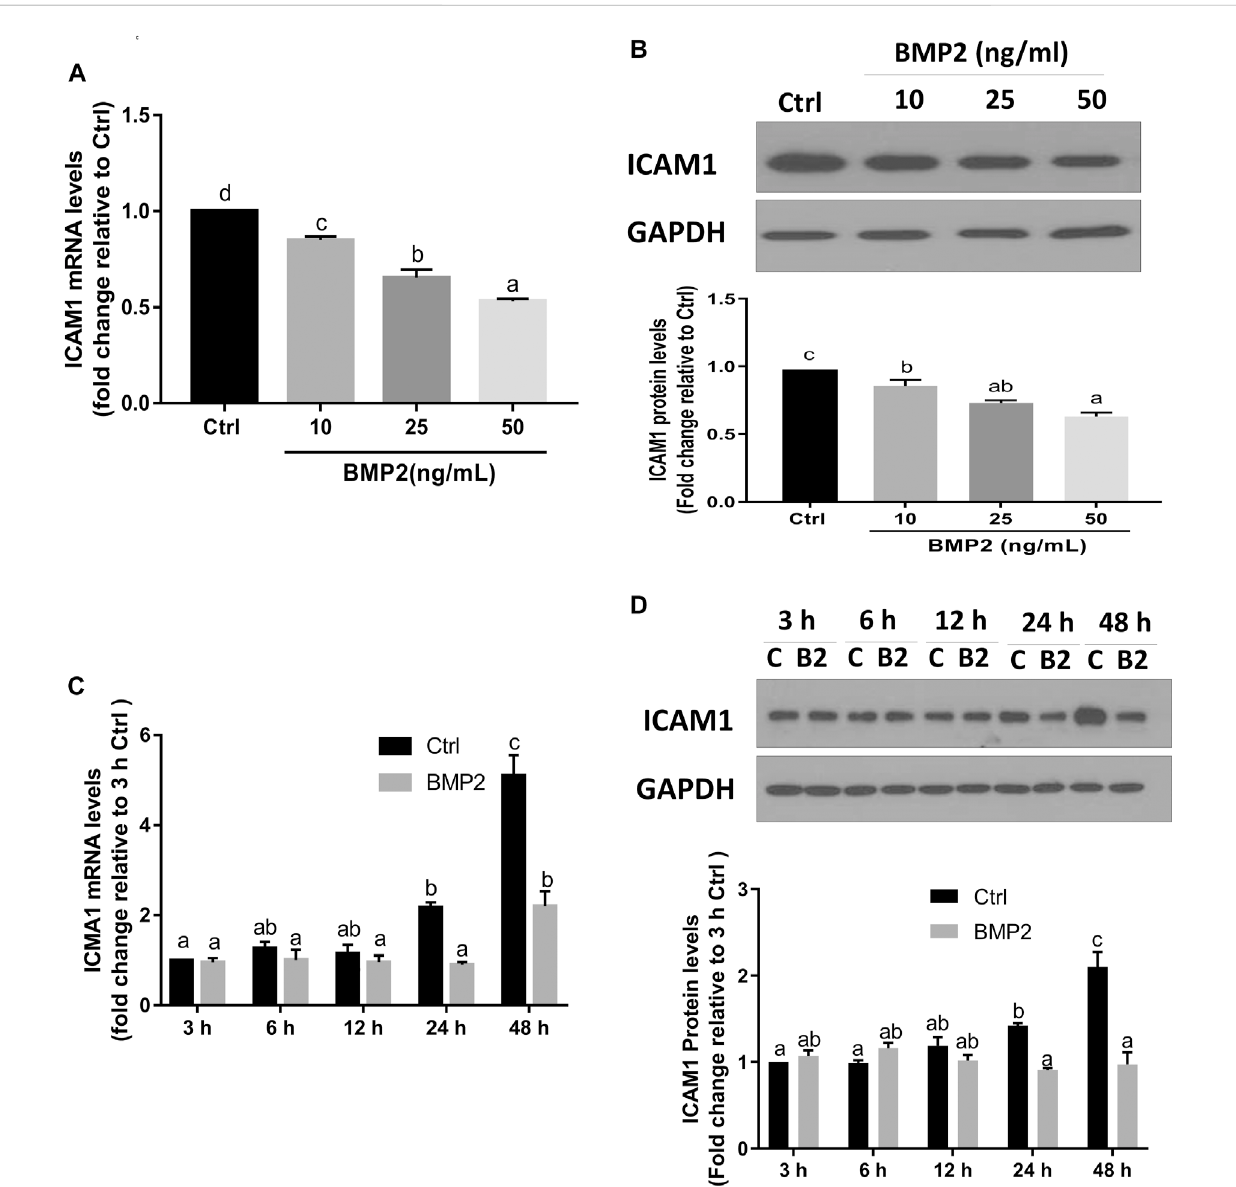
FIGURE 2 BMP2downregulatestheexpressionofICAM1innon-decidualizedHESCs. (A,B) HESCsweretreatedwithdifferentconcentrations(0,10,25,50 ng/ mL) of recombinant human BMP2 (BMP2) for 24 h, and the mRNA (A) and protein (B) levels of ICAM1 were examined using RT-qPCR and Western blot analysis, respectively. (C,D) HESCs were treated with 25 ng/mL of BMP2 for 3, 6, 12, 24 or 48 h, and the mRNA (C) and protein (D) levels of ICAM1 were examined using RT-qPCR and Western blot analysis, respectively. The results are expressed as the mean ± S.E.M. of at least three independent experiments.Different letters indicate signi fi cant adifference ( p < 0.05). Indetail, ifthe letters on twocolumns are different(E.g., “ a ” vs. “ b ” or “ b ” vs. “ c ” ),